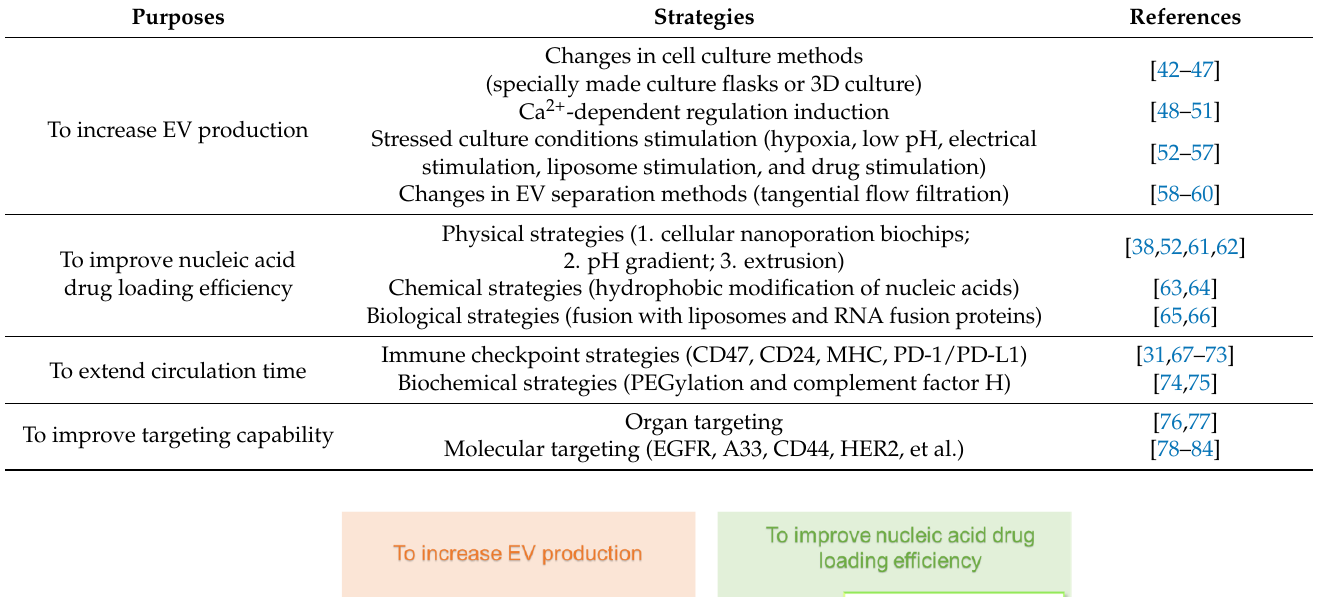
Table 1. A summary of EV modification strategies.